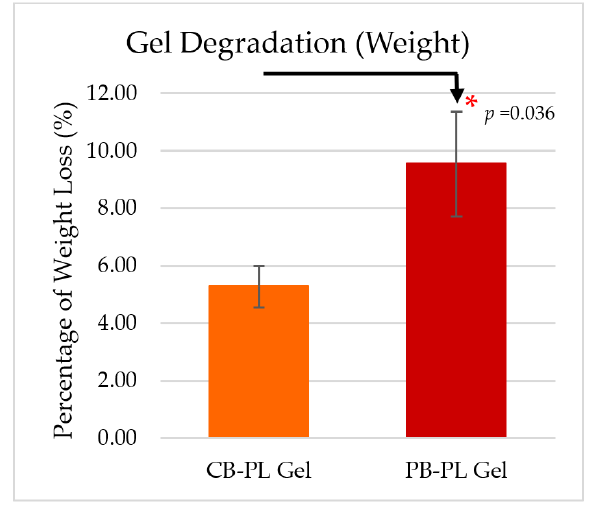
Figure 4. The percentage of gel degradation was evaluated on day 3 based on four independent tests ( n = 4). The means ± SEM were reported. Statistical significance between PB-PL gel and CB-PL gel was indicated by * p < 0.05.